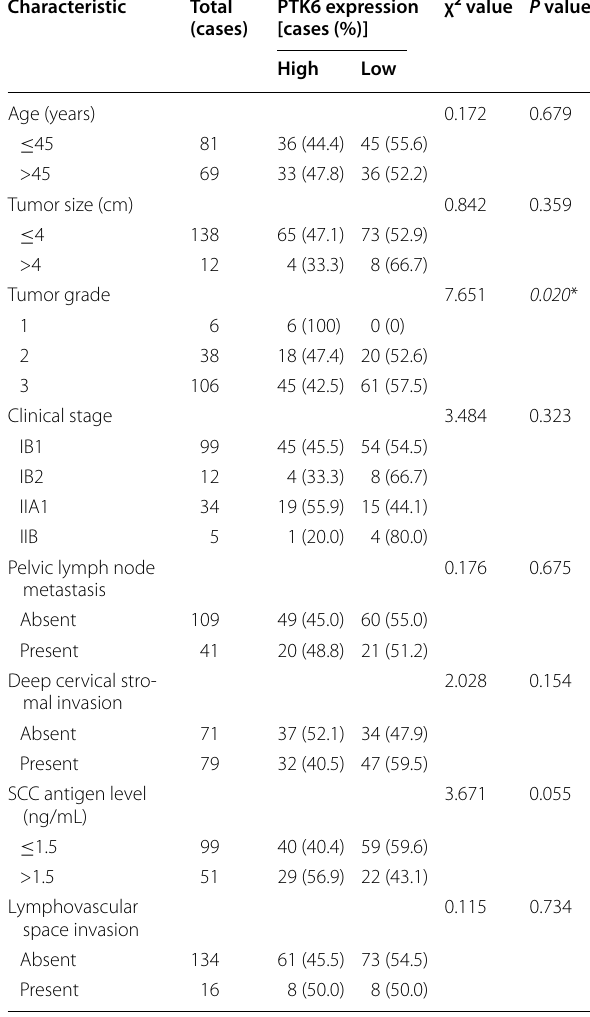
SCC squamous cell